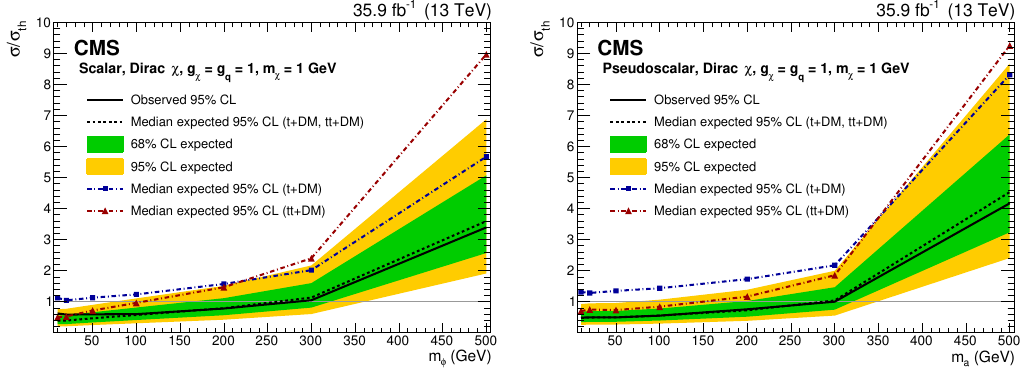
Figure 6 . The expected and observed 95% CL limits on the DM production cross sections, relative to the theory predictions, shown for the scalar (left) and pseudoscalar (right) models. The expected limit for the t = t+DM signal alone is depicted by the blue dash-dotted line, while the tt+DM limit alone is given by the red dash-dotted line. The observed limit on the sum of both signals is shown by the black solid line, while the expected value is shown by the black dashed line with the 68 and 95% CL uncertainty bands in green and yellow, respectively. The solid horizontal line corresponds to (cid:27)=(cid:27) th = 1.